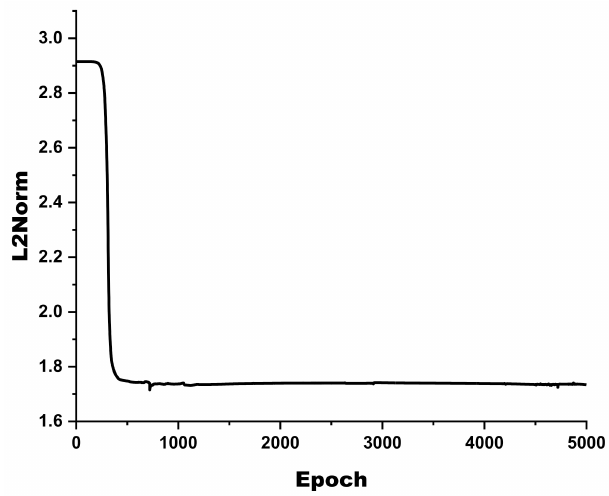
Figure 11. The converge norm of the gnLSTM model.